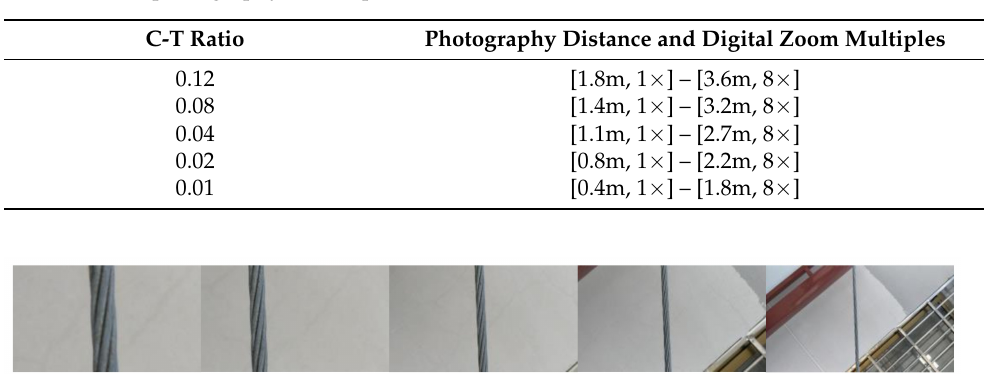
Table 2. Video photography related parameters.